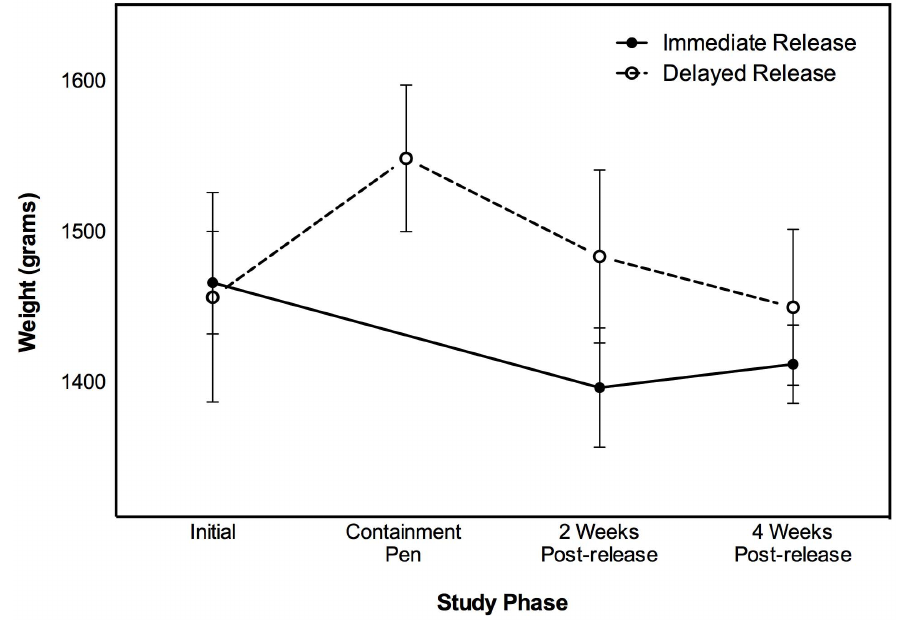
Figure 1. Weights of immediate (n=8) and delayed (n=6) release burrowing bettongs. The arrow indicates when release pen was first opened and delayed release animals allowed access to the Northern Paddock. Bars denote 1 standard error.